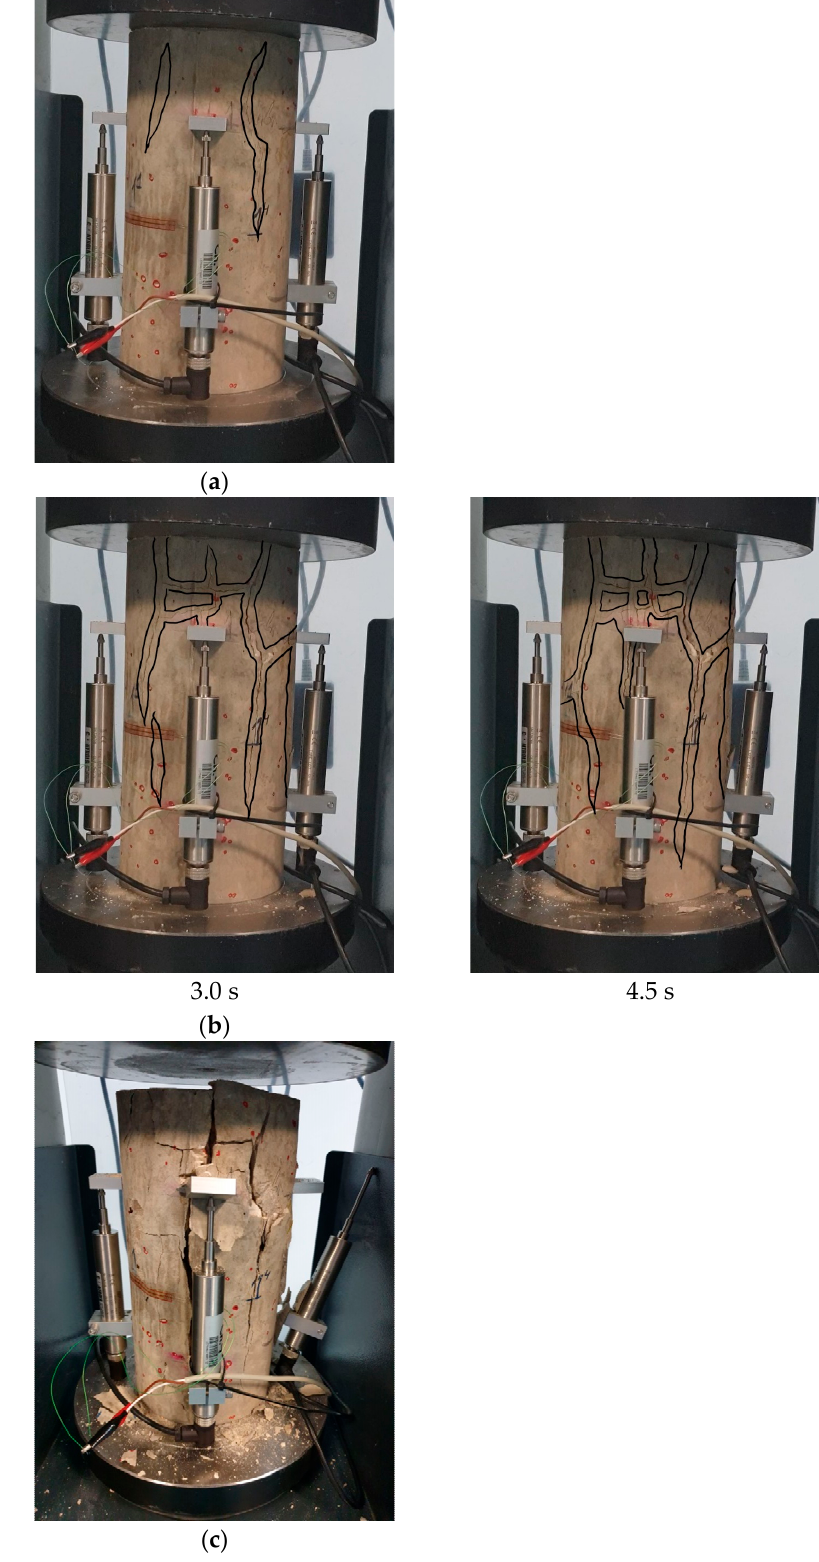
Figure 10. Typical crack propagation in the investigated specimens: ( a ) End of stage 1–crack development initiation; ( b ) Stage 2–crack development process; ( c ) Stage 3–specimen failure.